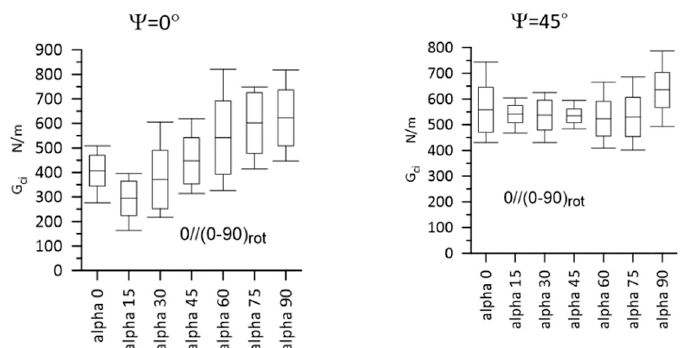
Figure 13. Gci values for Laminate A, for Ψ = 0 ◦ and Ψ = 45 ◦ . Statistically, a significant difference was detected for Ψ = 0 ◦ , for α = 0 ◦ vs. α = 90 ◦ ; α = 15 ◦ vs. α = 60 ◦ ; α = 30 ◦ vs. α = 75 ◦ ; α = 30 ◦ vs. α = 90 ◦ . The whiskers limit the extreme values, the middle bars represent the mean values, and the boxes represent the standard deviations.